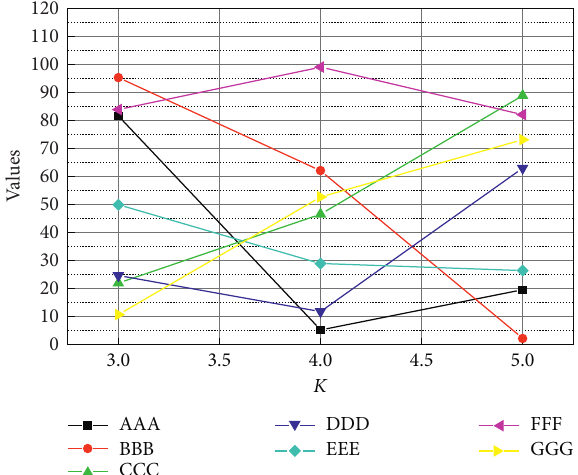
Figure 7: Factor decomposer accuracy variation curve.